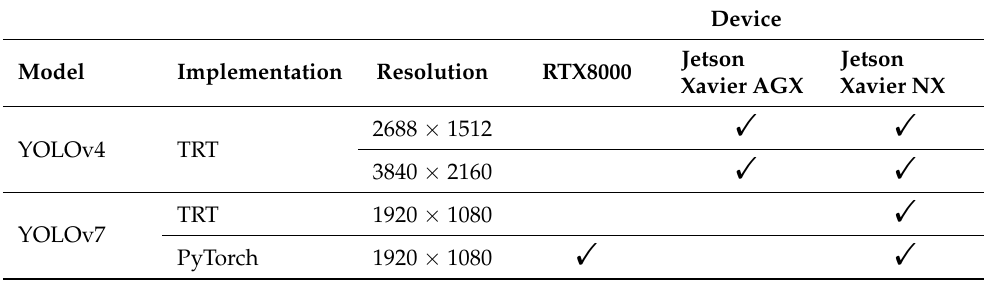
Table 3. Conducted experiments on different devices, object detection models, frameworks, and input video resolutions.